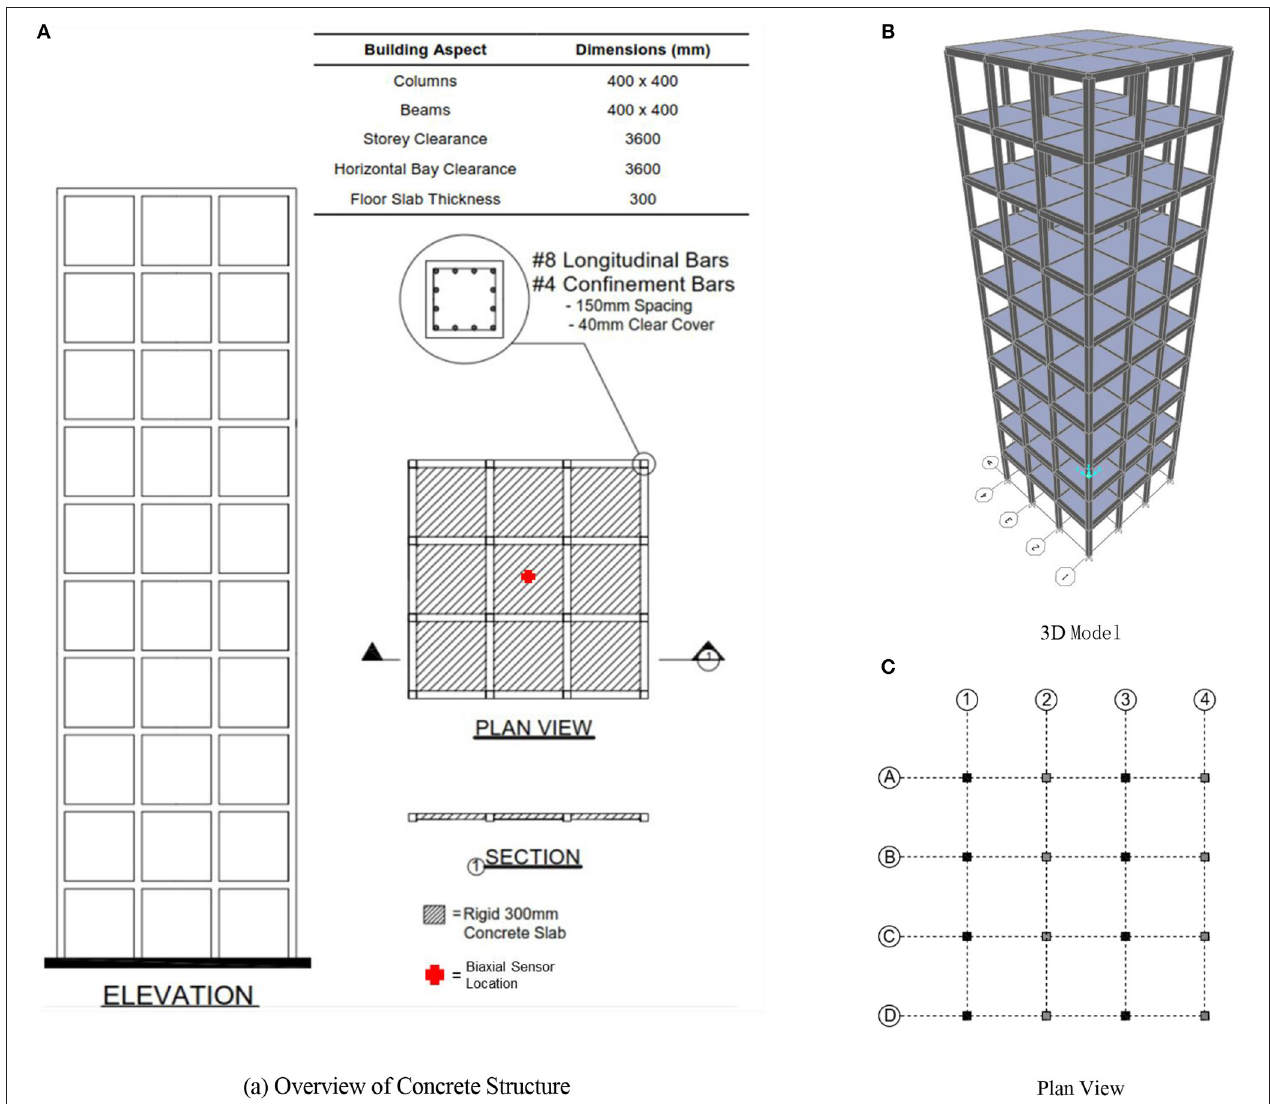
FIGURE 7 | Overview and FE model for concrete structure. (A) Overview of concrete structure. (B) 3D model. (C) Plan view.